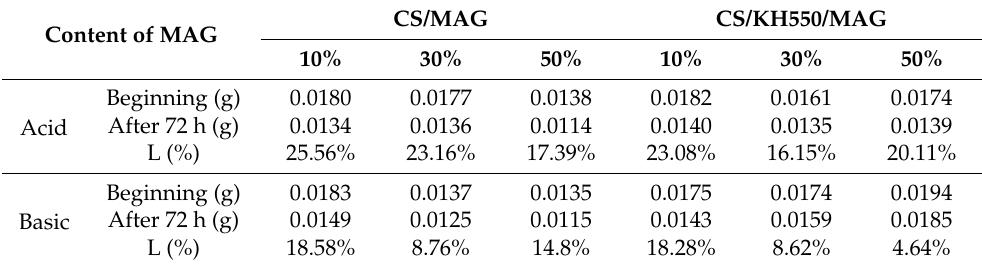
Table 1. The mass change of CS/MAG and CS/KH550/MAG after 72 h in acidic or basic environments (the concentration of HCl and NaOH solutions were 1 M, and the squares of membranes were 1 cm × 1 cm).